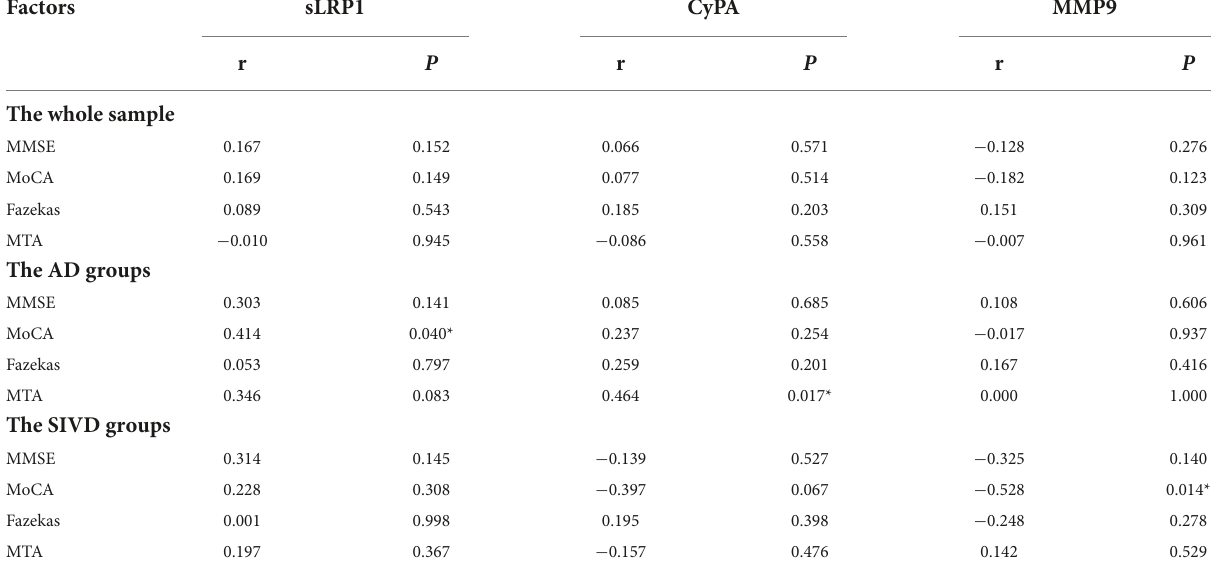
TABLE 3 Correlation of plasma biomarker levels with cognitive scores and imaging parameters.